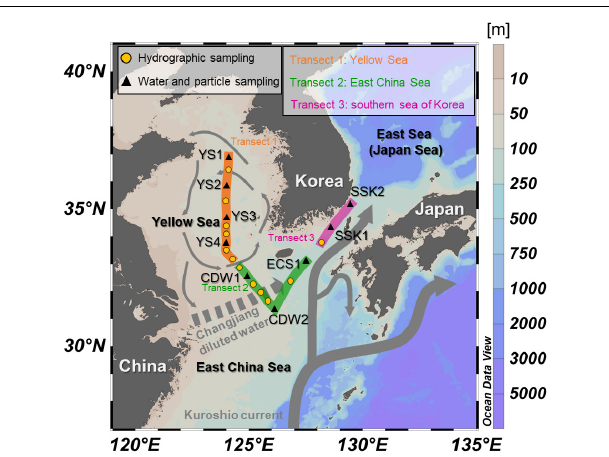
FIGURE 1 | Bathymetric map showing the locations of sampling stations in the study region. Triangles indicate sites where water sampling and particle filtration were performed, and circles indicate hydrographic sampling sites. Transects 1, 2, and 3 represent the Yellow Sea (YS), the East China Sea (ECS), and the southern Sea of Korea (SSK), respectively. The arrows indicate current systems in operation during the sampling period.